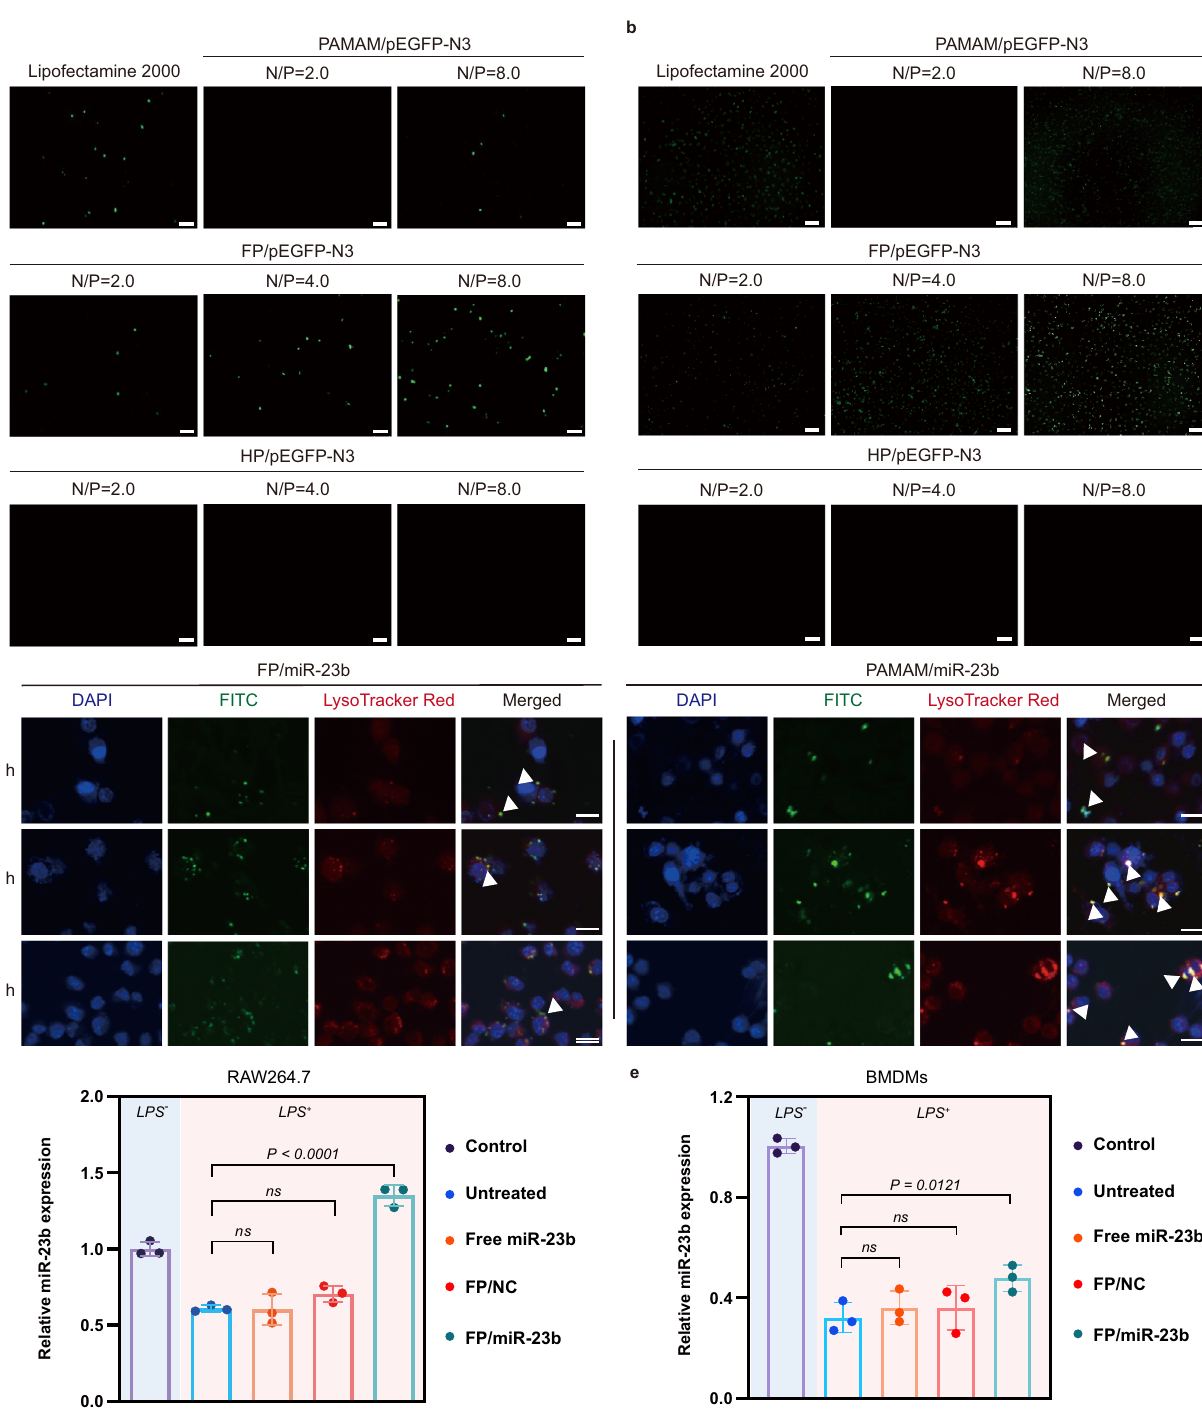
the lysosomes. Scale bar: 20 μ m. A representative image of three biologically independentexperimentsfromeachgroupisshownin( a – c ). d , e RelativemiR-23b expression in LPS-stimulated RAW264.7 cells ( d ) and BMDMs ( e ) treated with dif- ferent groups. LPS − represents the cells without lipopolysaccharide stimulation, andLPS + groupsrepresentthecellstreatedwithlipopolysaccharide(0.1 μ